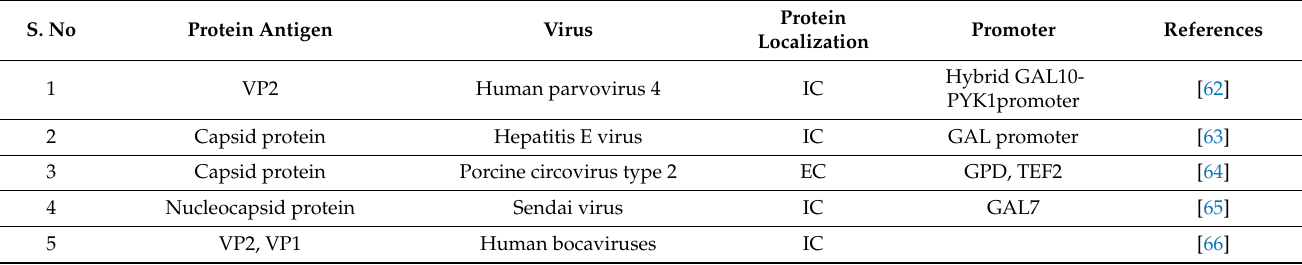
Table 2. Studies in which S. cerevisiae yeast was used to generate